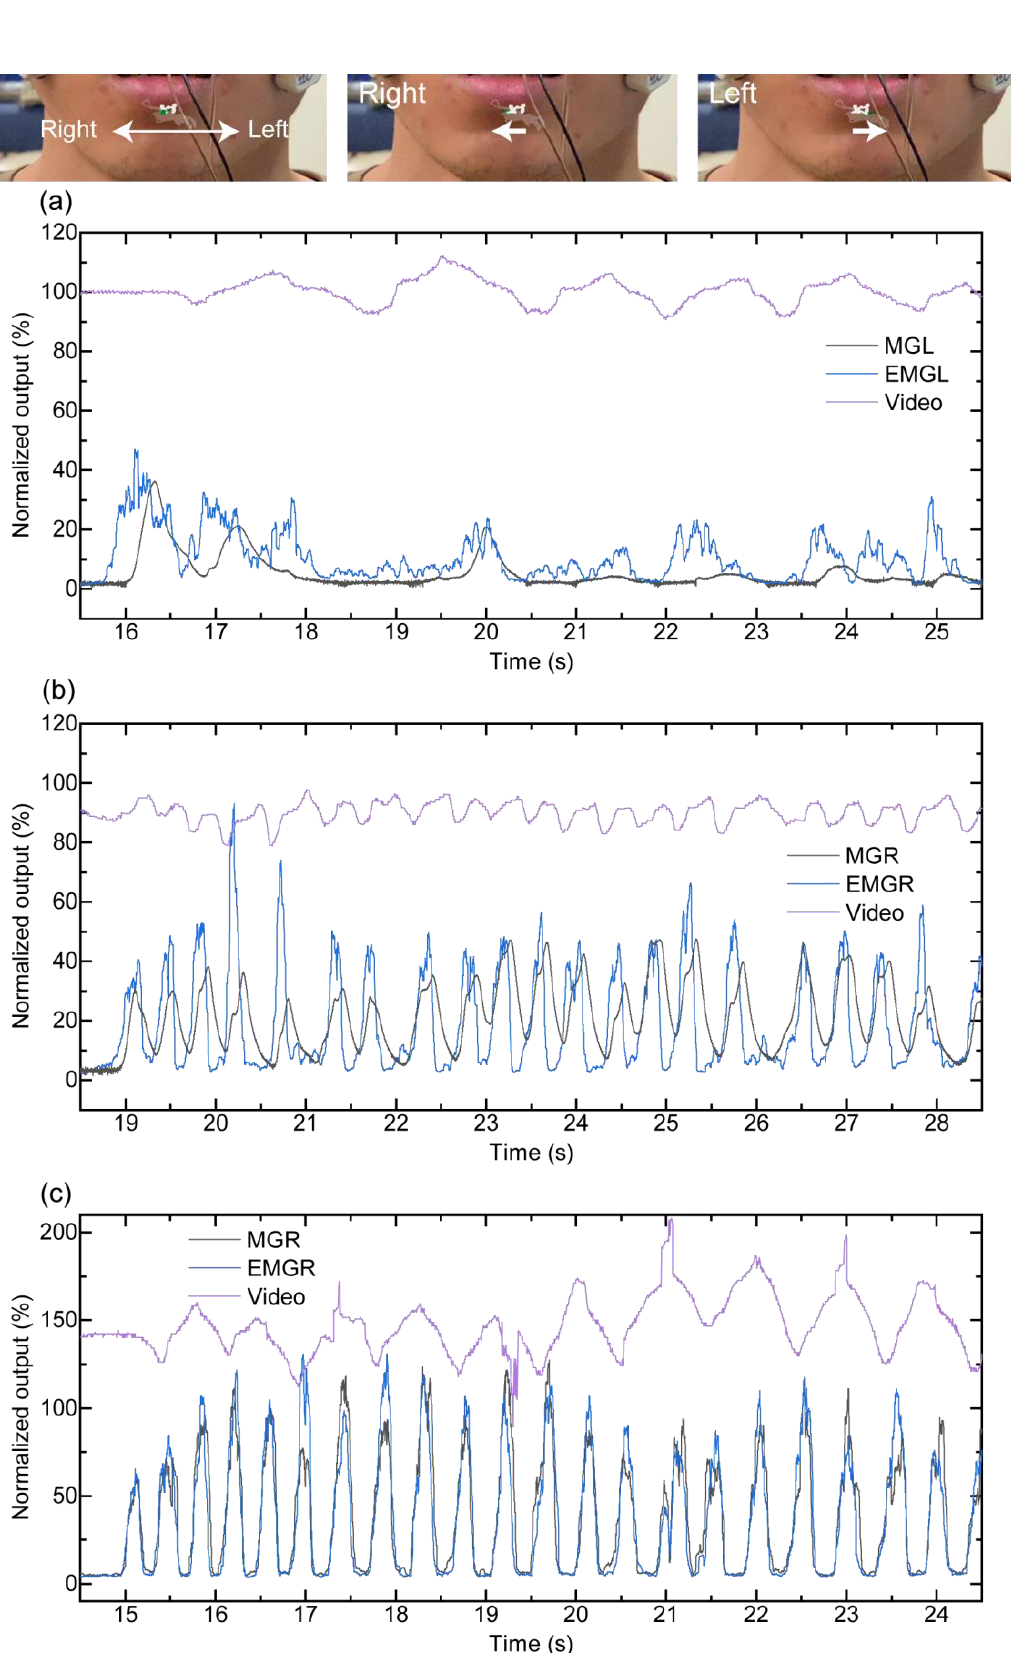
Figure 6. Sensors compared with the video-motion analysis during the grinding task for each participant: ( a ) participant A, ( b ) participant B, and ( c ) participant C. Video analysis shows how the median of the mandible moves to the left and right sides with respect to the median of the maxilla.